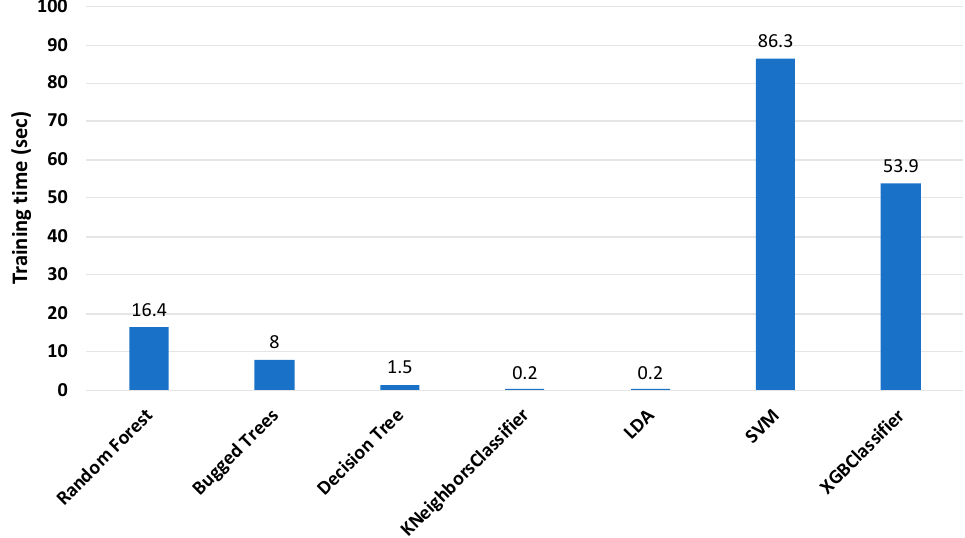
Figure 9. Training time of classifiers with 25 features (sensor 2).